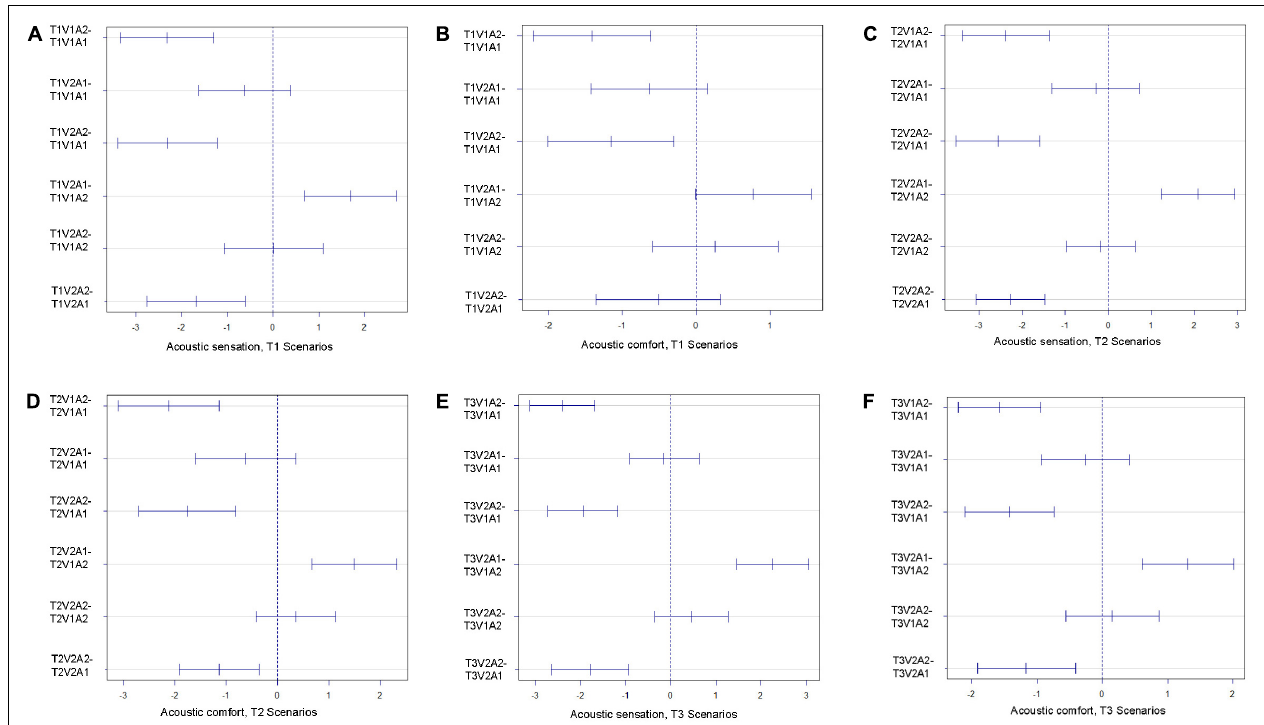
FIGURE 8 | Differences in mean levels of acoustic sensation (A) and comfort (B) votes in T1 Scenarios, acoustic sensation (C) and comfort (D) votes in T2 Scenarios, and acoustic sensation (E) and comfort (F) votes in T3